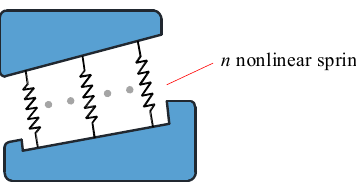
Figure 3. Replace rollers with nonlinear spring elements.